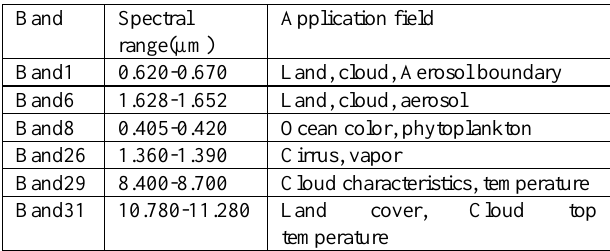
Table1.the spectral range and application field of the MODIS bands for the cloud detection Cloud detection employs the normalized difference cloud index two bands divided by the sum of the two